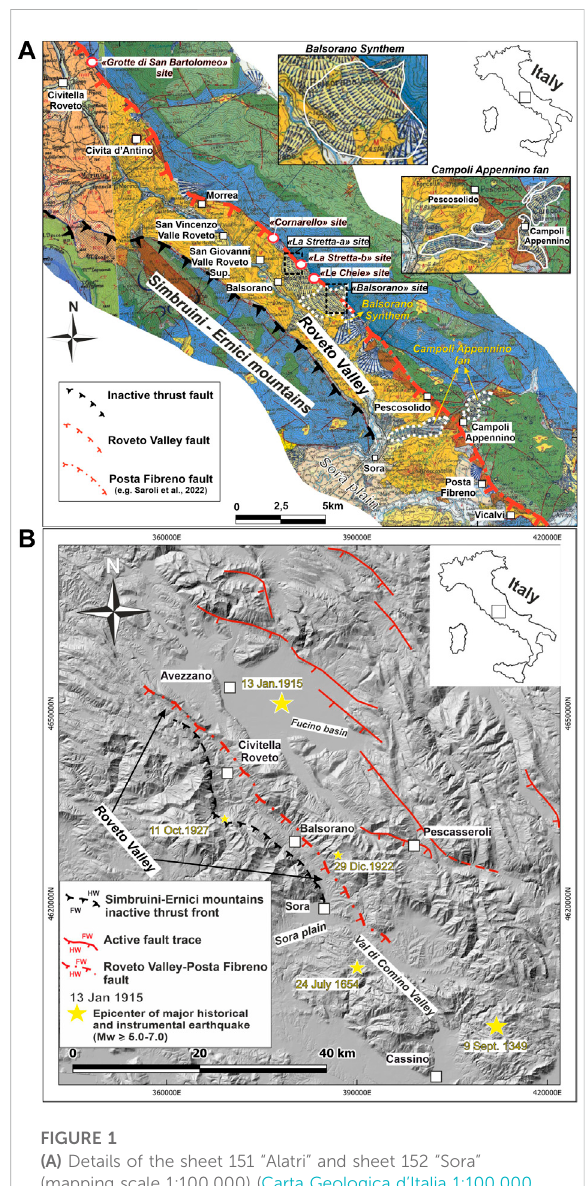
FIGURE 1 (A) Details of the sheet 151 “ Alatri ” and sheet 152 “ Sora ” (mapping scale 1:100.000) (Carta Geologica d ’ Italia 1:100.000, 1941a, Carta Geologica d ’ Italia 1:100.000, 1941b) of the geological mapofItalyofthesouthernAbruzzoandLazioregionswhere the study area is located and details of the Campoli Appennino fan and the Balsorano Synthem (insets). (B) Digital terrain model (shaded relief) of the sector of the Central Apennines between the southern Abruzzo and the south-eastern Lazio regions; trace of the Roveto Valley – Posta Fibreno Fault, red dash-dotted